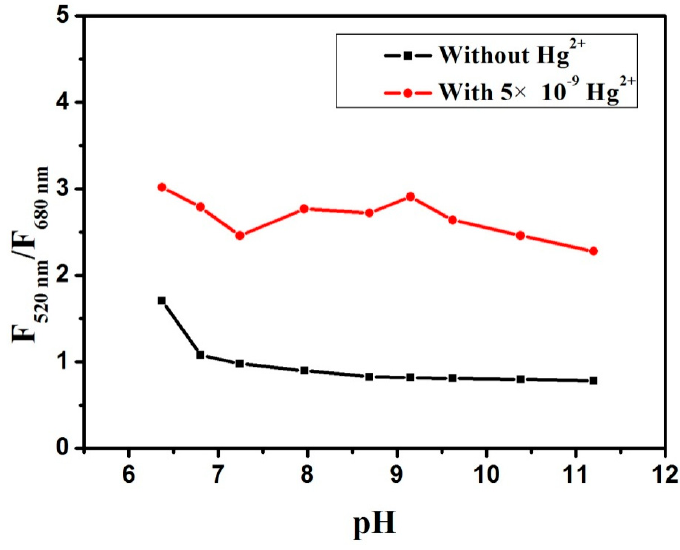
Figure 4. The F 520nm / F 680nm intensity of RFN under the di ff erent of pH.